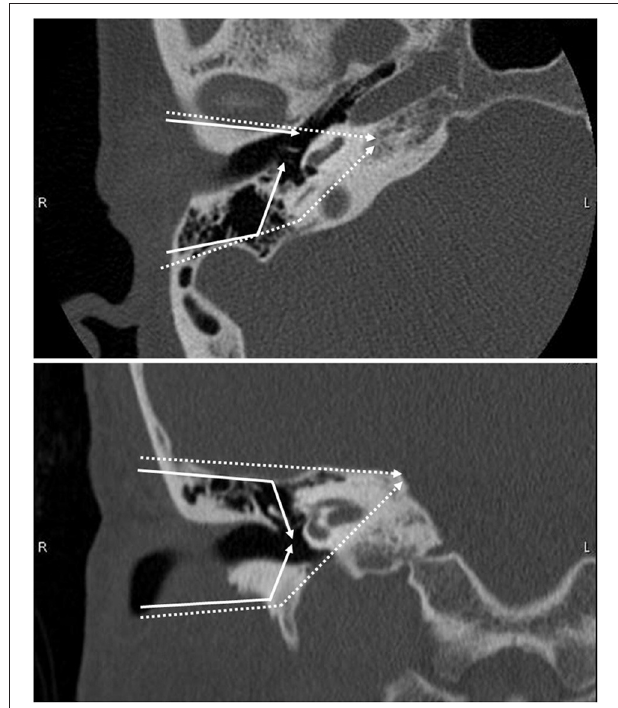
FIGURE 1 | Schematic CT images showing the resection line of lateral temporal bone resection. Upper panel : axial image. Lower panel : coronal image. Solid line shows the resection line of LTBR. Dotted line shows the resection line of